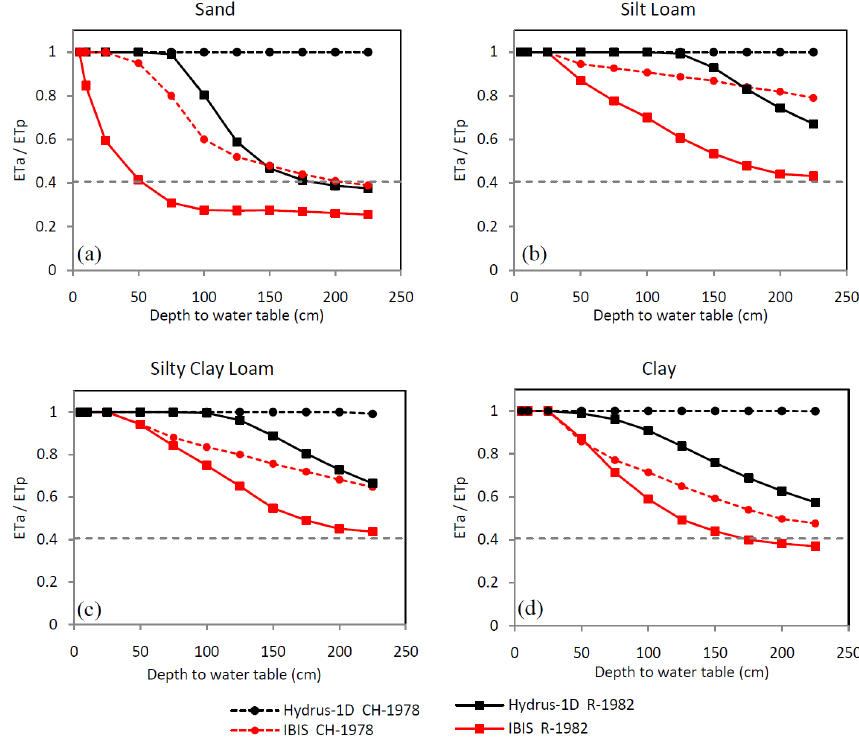
Fig. 5. Same as in Fig. 4, except for hourly Hydrus-1D (black) and IBIS (red) 10-year simulations (see Table 3). The node spacing in all simulations is 2.5cm, and ET p is calculated based on ET a from the “saturated” IBIS run. 4